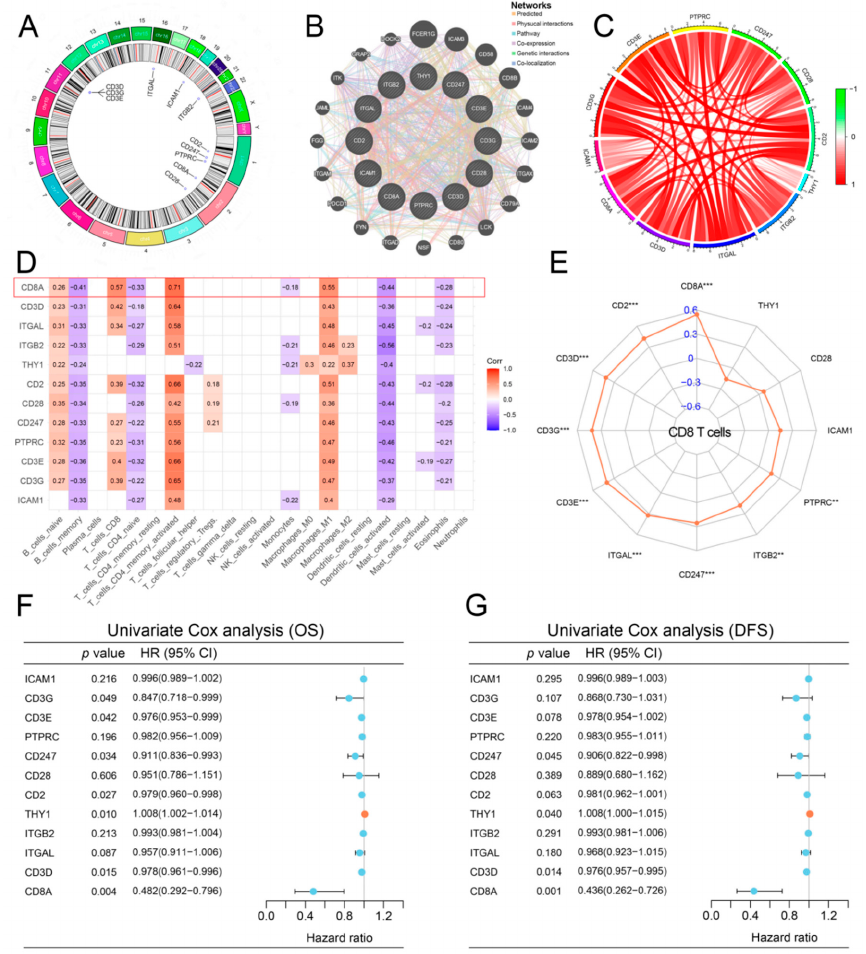
Figure 2. Identification of hub gene of T cytotoxic pathway in BCa. ( A ) Locations of T cytotoxic pathway-related genes on 23 chromosomes. ( B ) Interaction of T cytotoxic pathway-related genes. ( C ) Correlation analysis among T cytotoxic pathway-related genes. ( D ) Correlation analysis between T cytotoxic pathway-related genes and TIICs. ( E ) The association of the CD8+ T cells with T cytotoxic pathway-related genes. ( F , G ) Univariate Cox analyses of the T cytotoxic pathway-related genes in BCa. BCa, bladder cancer; TIICs, tumor-infiltrating immune cells; OS, overall survival; DFS, disease-free survival. **: p < 0.01, ***: p < 0.001.